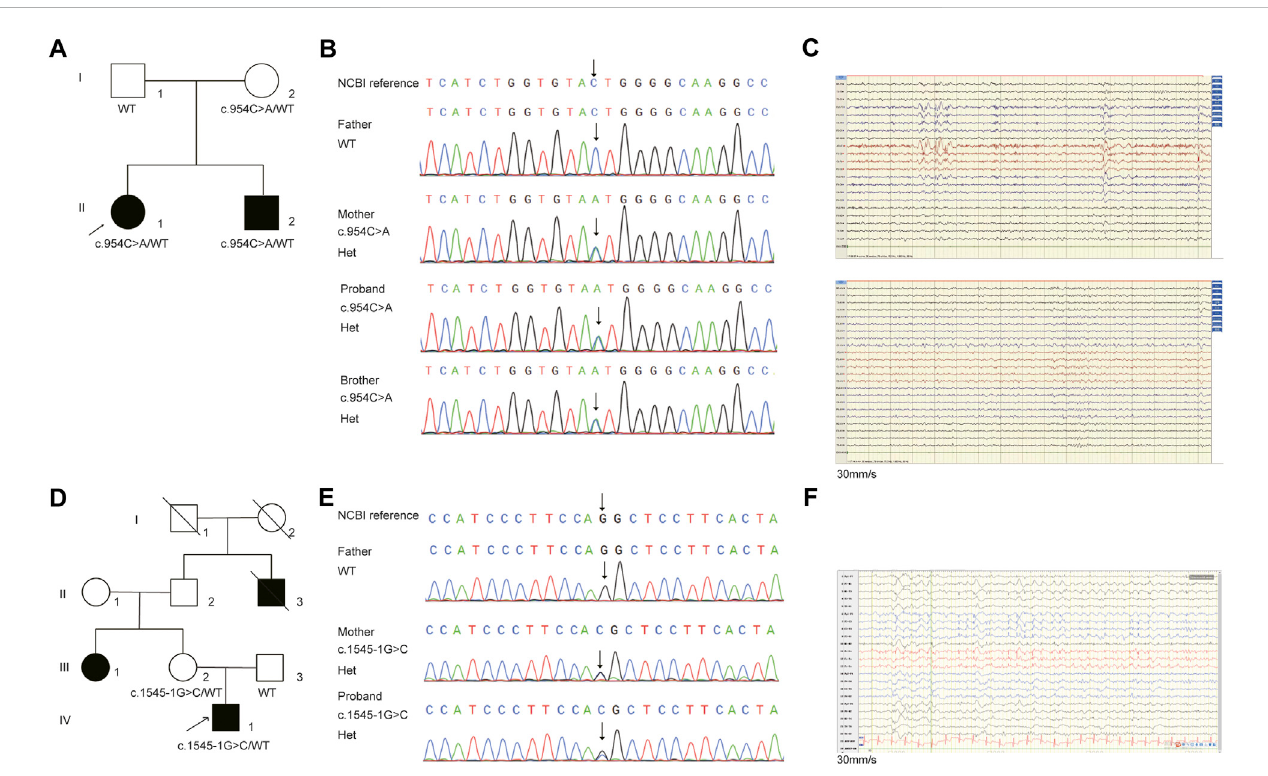
FIGURE 2 The pedigree and Sanger sequencing validation of (C) 954C > A and (C) 1545-1G > C in NPRL3 gene. (A) Pedigrees of affected family E1. Squares and circles indicatemalesandfemales,respectively.Arrowsindicatetheproband. (B) DNAsequencingdataofthemutationidenti fi edinthefamilyE1.Thearrowindicates the location of the mutation. (C) EEG of the patients. Above: EEG of the patient II1 in family E1 showing diffuse paroxysms of irregular spike waves in the left hemisphere, with prominent anterior head. Below: EEG of the patient II2 in family E1 showing frequent spike-slow wave complexes in the left posterior head (O1, P3). (D) Pedigrees of affected family E2. Squares and circles indicate males and females, respectively. Arrows indicate the proband. (E) DNA sequencing data of the mutation identi fi ed in the family E2. The arrow indicates the location of the mutation. (F) EEG of the patient in family E2 showing persistent spike-slow wave complexes in left central, parietal and midline areas (C3, P3, Cz,